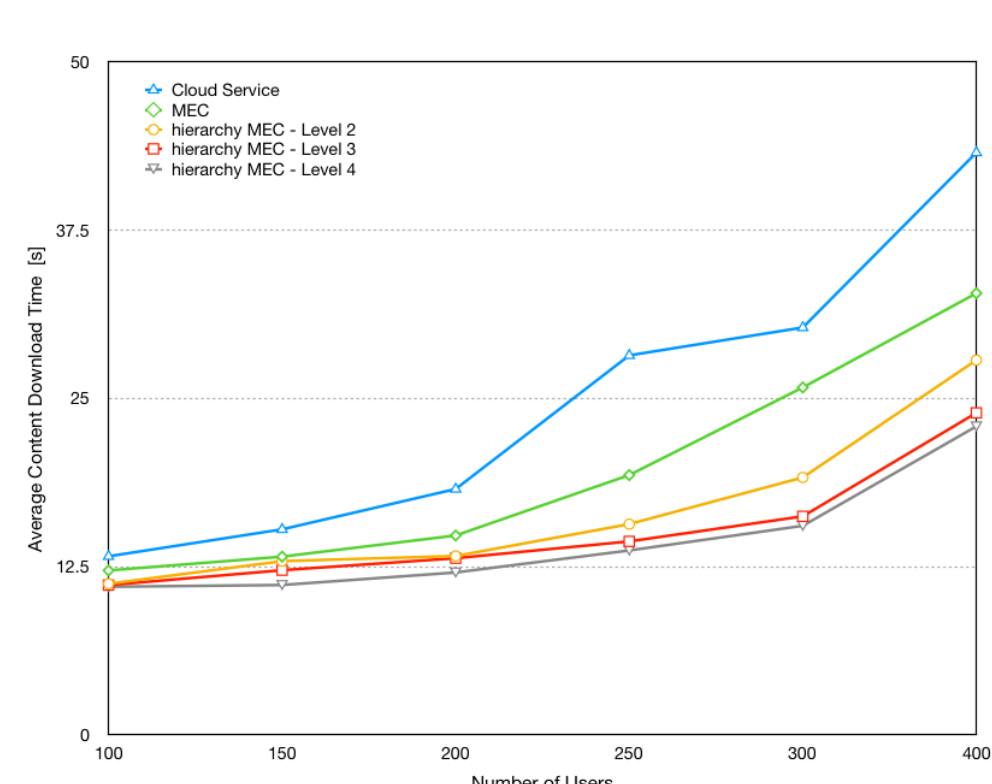
Figure 10. Average content download